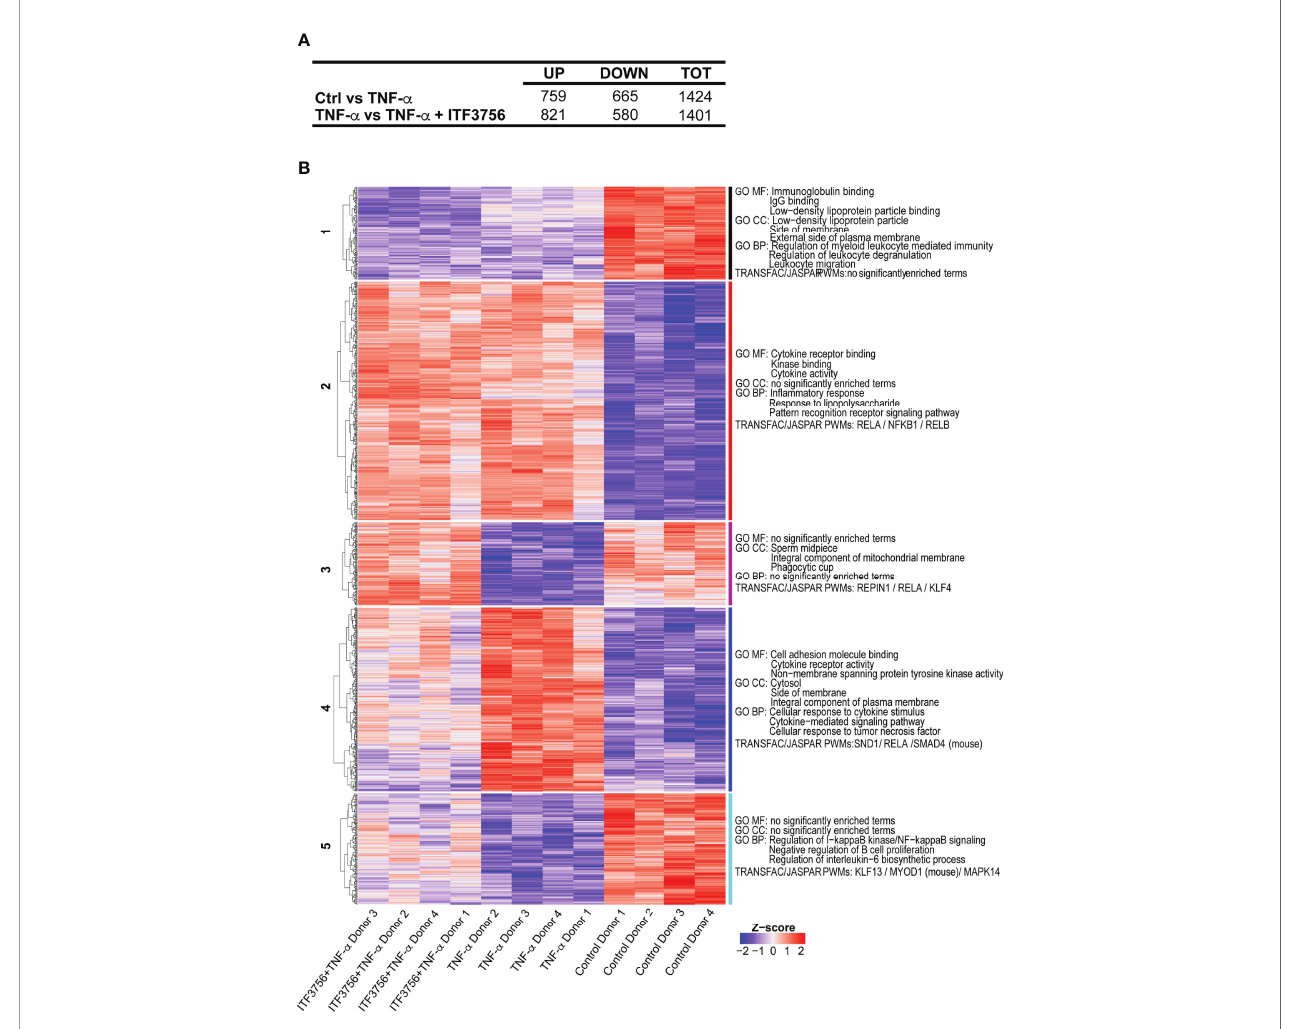
FIGURE 4 | ITF3756 dampens the pro-in fl ammatory program induced by TNF- a in monocytes. Human monocytes pre-treated with ITF3756 1 m M were stimulated with TNF- a (100ng/ml) for 4h. RNASeq analysis was performed on 4 different donors. (A) Summary of signi fi cantly differently expressed genes (DEGs). Up- and down- regulated genes were de fi ned as follows: -1< log 2 (Fold change) <1 and padj<0.01. (B) The heatmap shows hierarchical clustering of RNASeq data of monocytes stimulated or not with TNF- a and treated with ITF3756. Gene Ontology of Molecular Function (MF), Biological Processes (BP) and Transcription Factor Binding motif enrichment (TRANFAC/JASPAR PWMs) is reported for each cluster. Top 3 gene sets per clusters are